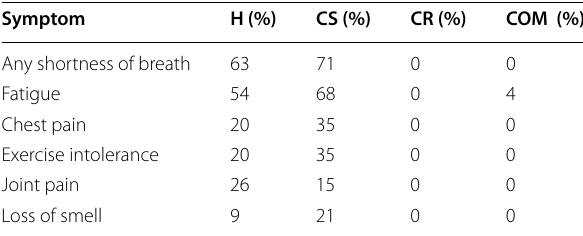
Table 2 Prevalence of symptoms across all groups